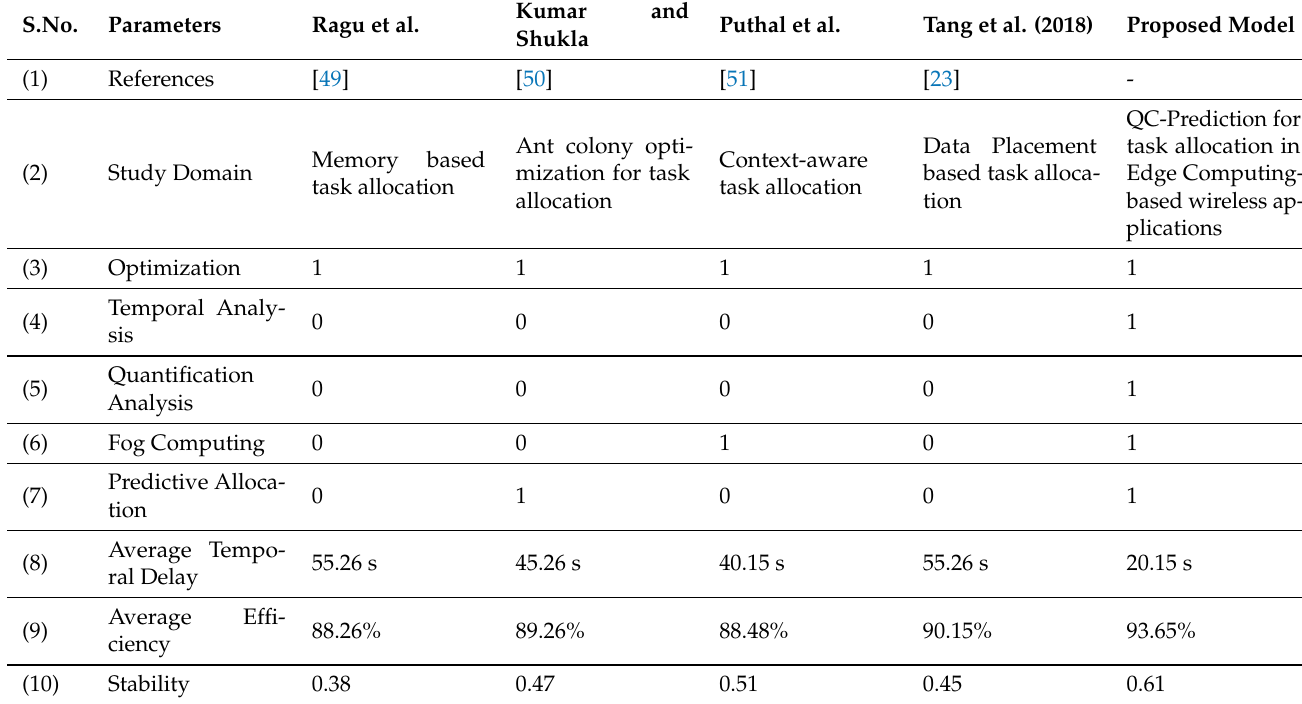
Table 7. State-of-the-Art Comparison Analysis (1 Yes, 0